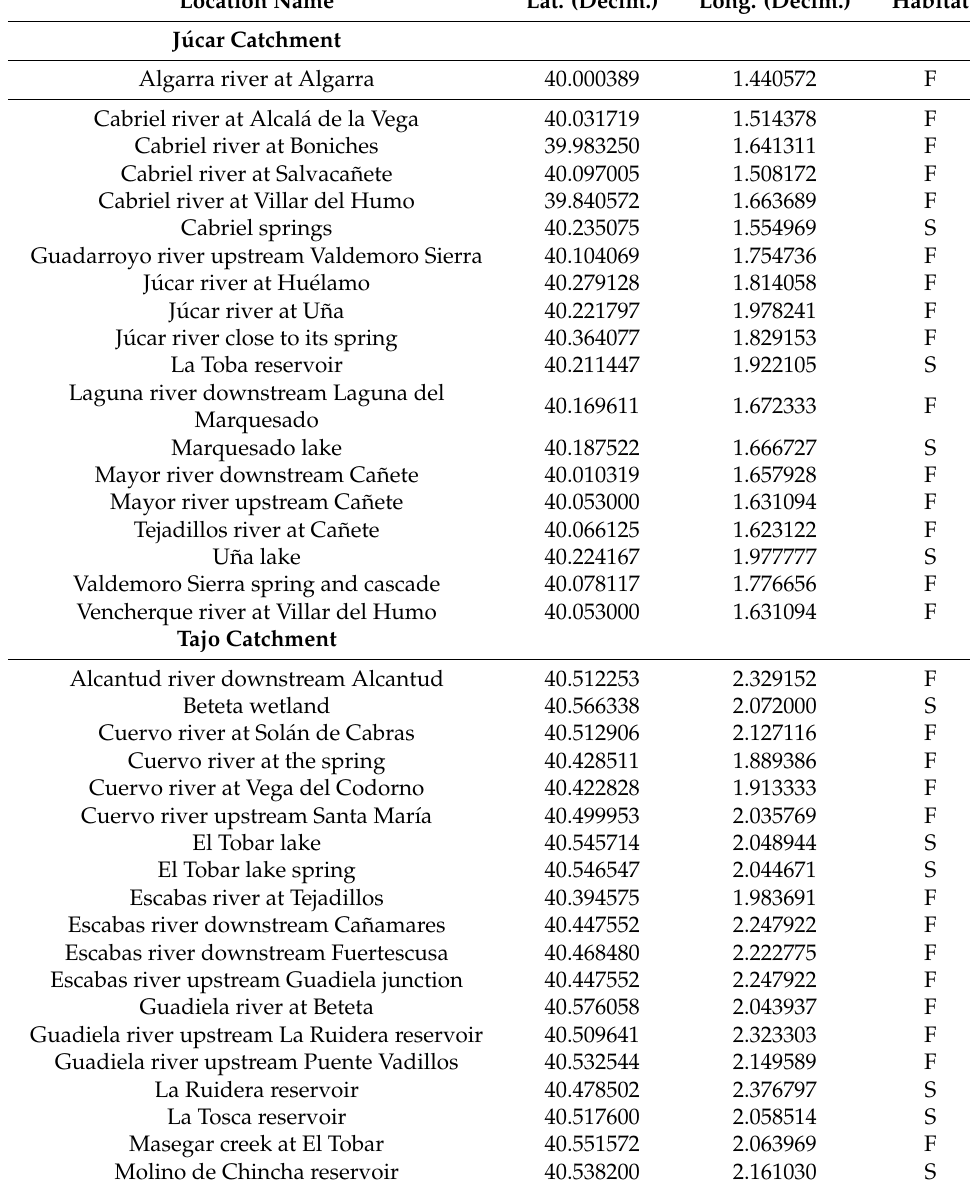
Table 2). Their altitude ranged from 840 masl to 1600 masl (average slopes of 4–20%). These 36 locations were visited once over a couple of weeks in summer (August 2017). Table 2. Sampling locations in Serran í a de Cuenca (2017). Catchments, coordinates and type of habitat (S: stagnant waters, F: flowing waters) are